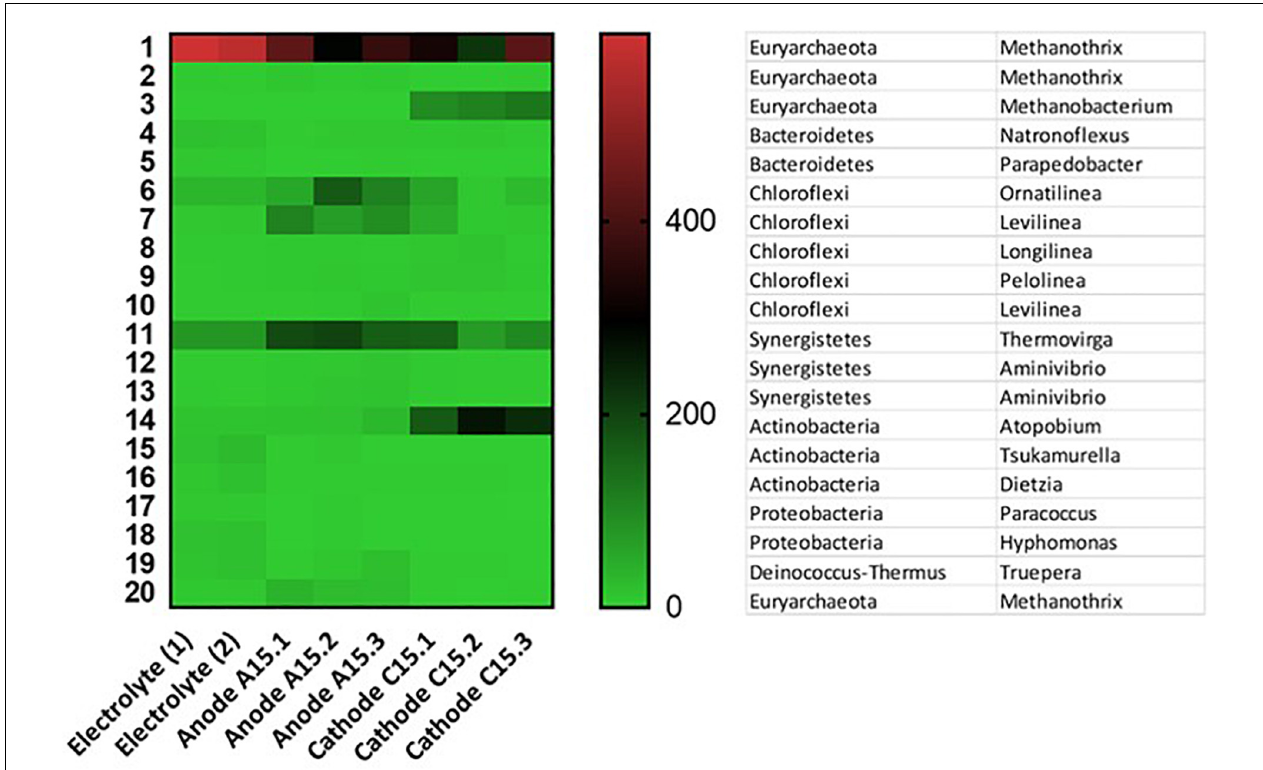
) of the 20 most abundant microorganisms (OTUs) identified in the electrolyte (2 replicates), anode and cathode biofilms of FIGURE 7 | Relative abundance ( module 15. (cid:104)